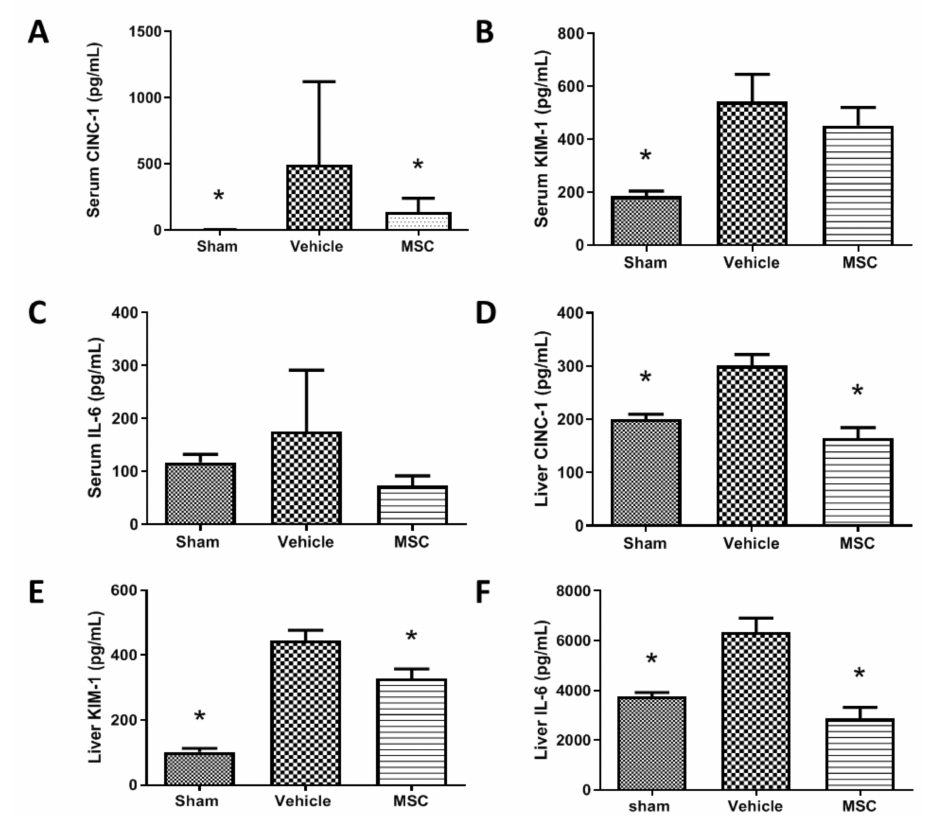
Figure 5. Systemic and organ inflammatory cytokine production after CD362 + UC-MSC administration. Serum levels of CINC-1 ( A ), KIM-1 ( B ) and IL-6 ( C ) are reduced in the CD362 + UC-MSC treated group compared with vehicle administration. In the liver, levels of CINC-1 ( D ), KIM-1 ( E ) and IL-6 ( F ) are reduced in the CD362 + UC-MSC treated group compared with vehicle administration. Bars represent mean ( n = 3 / 5 / 5), error bars represent SD. * Statistically significant ( p <